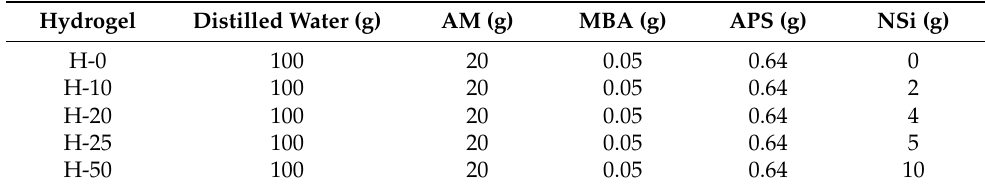
Table 1. Compositions of the hydrogels.